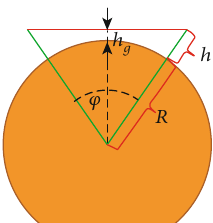
Figure 20: Minimum height range for the crosslink.